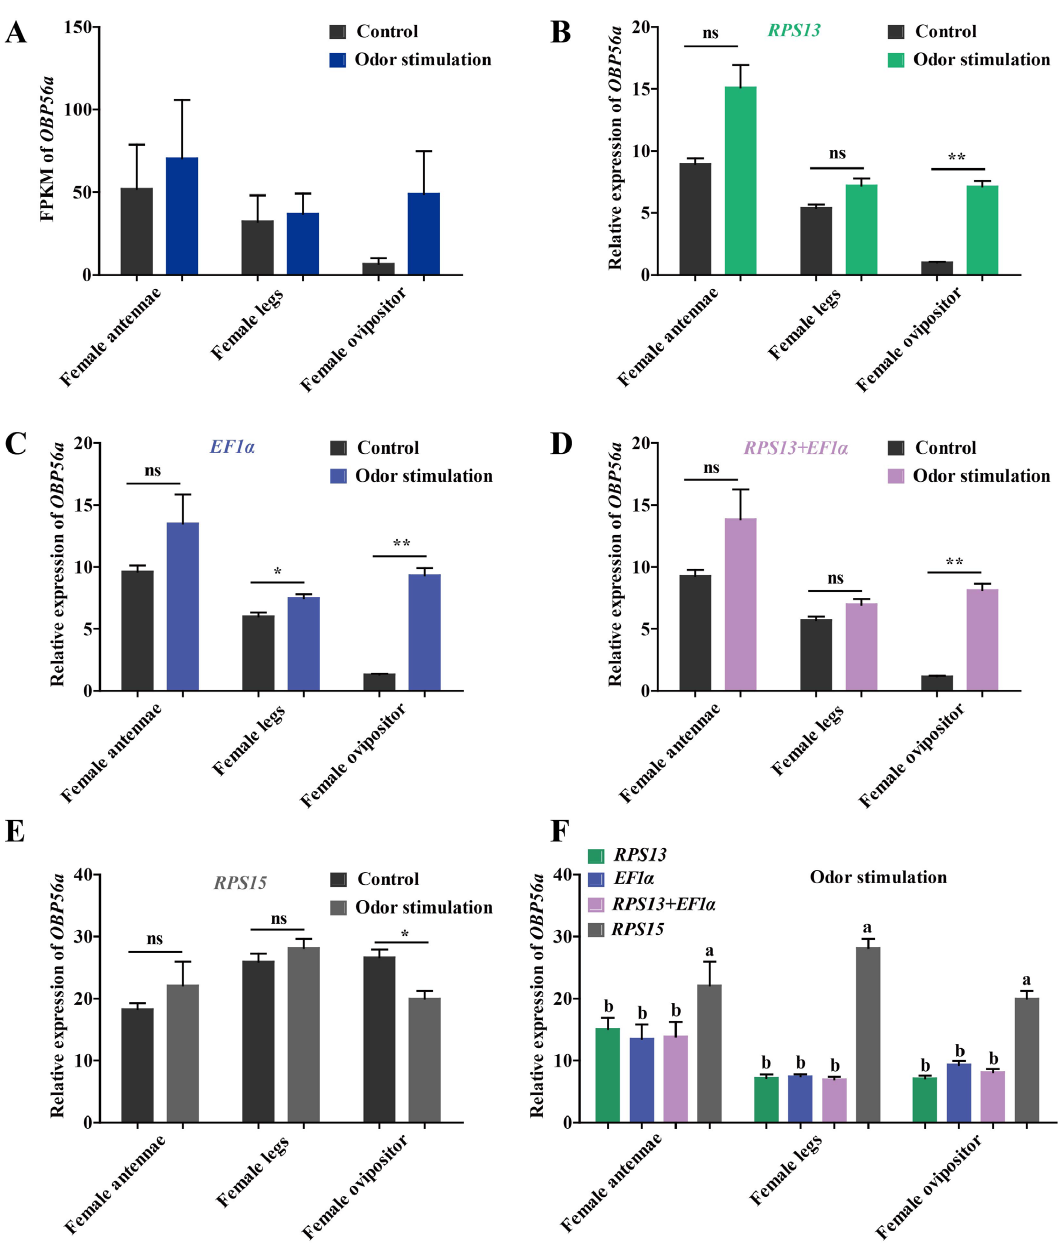
stable RGs: RPL32 and EF1 α , least stable RG: EF1 β ). The OBP56a expression in female ovipositor was used for normalization. Data are represented as the mean ± SE . Bars labeled with different letters are significantly different ( p < 0.05, ANOVA followed by Tukey’s HSD multiple comparison test, n = 3).